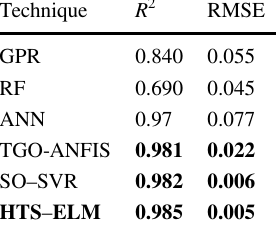
Bold indicates the